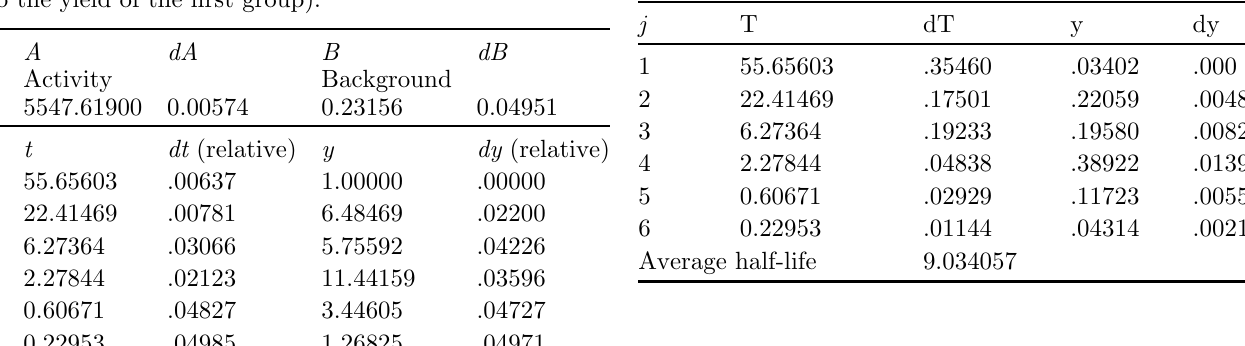
Table A1. Temporal DN parameters obtained in the result of the steps 1 – 3 (group yields are obtained relatively to the yield of the fi rst group).